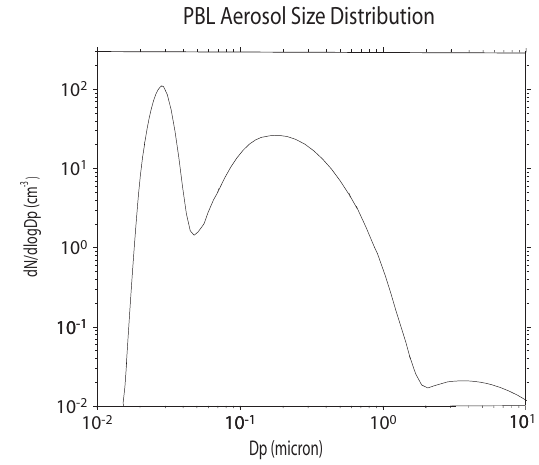
Fig. 3. Size distribution of the averaged aerosol over the